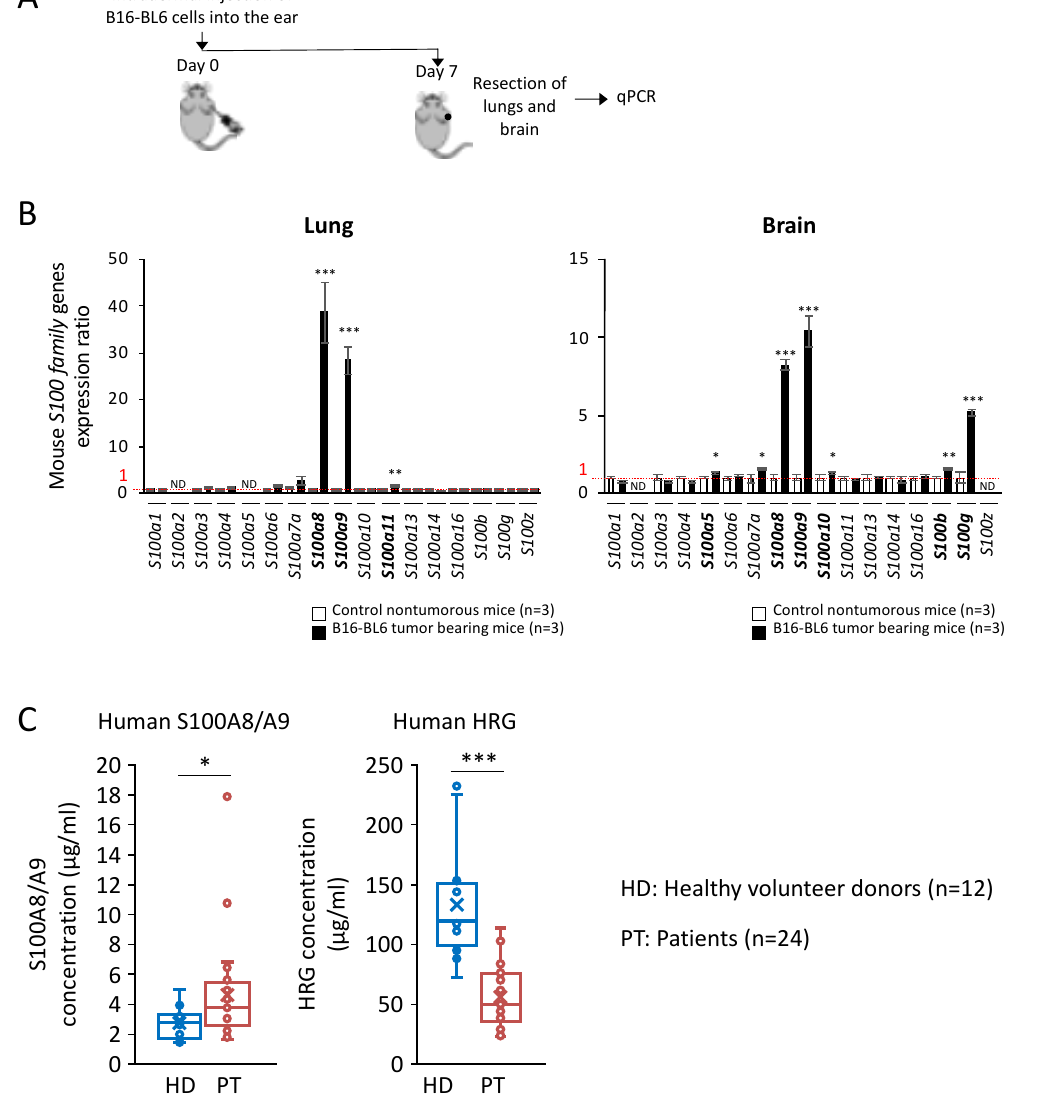
PT: Patients (n=24)